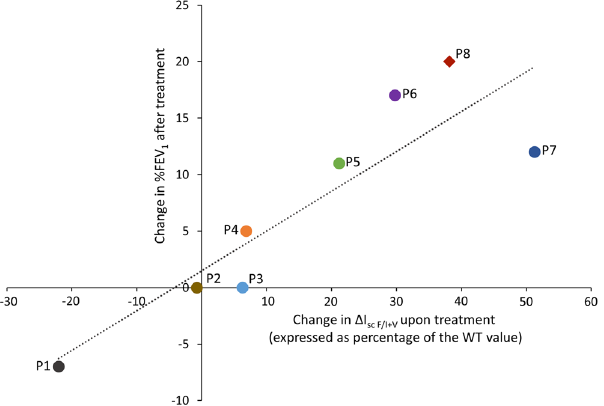
Figure 6. Correlation of CFTR modulators stimulated CFTR activity with changes in FEV 1 . Difference between ∆ I scF/I + V upon lumacaftor (3 µ M) + ivacaftor (100 nM) or ivacaftor (100 nM) alone (for Patient 8) for 48 h at 37 °C and ∆ I scF/I + V upon DMSO, expressed as percentage of the mean ∆ I scF/I + V value in wt/wt cells. Data from 7 F508del/F508del patients (P1 to P7) treated with Orkambi and patient (P8) carrying the F508del/S549N genotype treated with VX-770 ivacaftor. Correlation with changes in % FEV 1 after 6 months of treatment with Orkambi (P1 to P7) or ivacaftor (P8), respectively. The value of change in %FEV 1 upon treatment was obtained by the ratio of the absolute FEV1 value at 6 months of treatment minus FEV1 value just before starting treatment over absolute FEV1 value just before starting treatment for each individual patient. The value of change in Δ I scF/I + V upon treatment was obtained by the following formula: (( Δ I scF/I + V CFTR modulator – Δ I scF/I + V DMSO)/mean Δ I scF/I + V WT-CFTR) * 100. The two obtained values for each individual patient were used to calculate the correlation and generate the graphics with StatView software. The dotted line shows simple regression analysis of the data ( R 2 = 0.95; p < 0.0001). Circular points: F508del homozygous patients treated with Orkambi; rhomboid point: F508del/S549N patient treated with ivacaftor. Different colors correspond to different